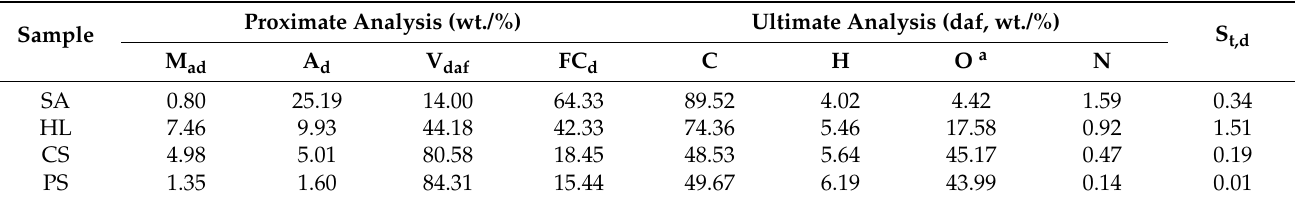
Table 1. Proximate and ultimate analyses of tested samples.